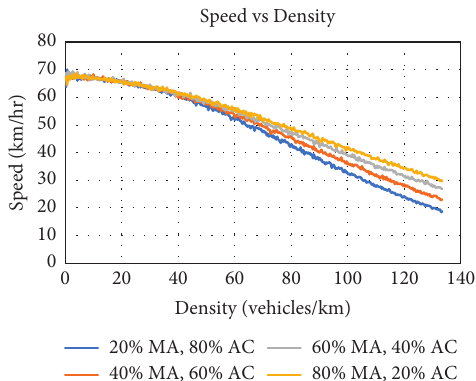
Figure 23: Speed vs. density fundamental diagrams for different compositions of MA and AC.